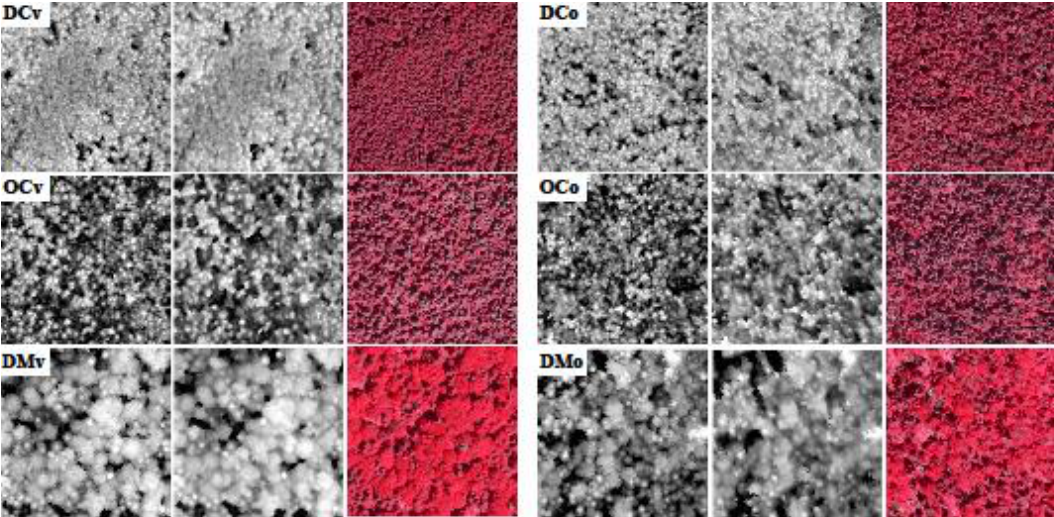
Figure 2. Lidar ( left ) and photogrammetric (PPC)-based ( middle ) canopy height models 250 m × 250 m excerpts (brightness proportional to height) with corresponding orthophoto ( right ) of the six sites. DC: dense conifers; OC: open conifers; DM: dense mixed woods; v: vertical; o: oblique.